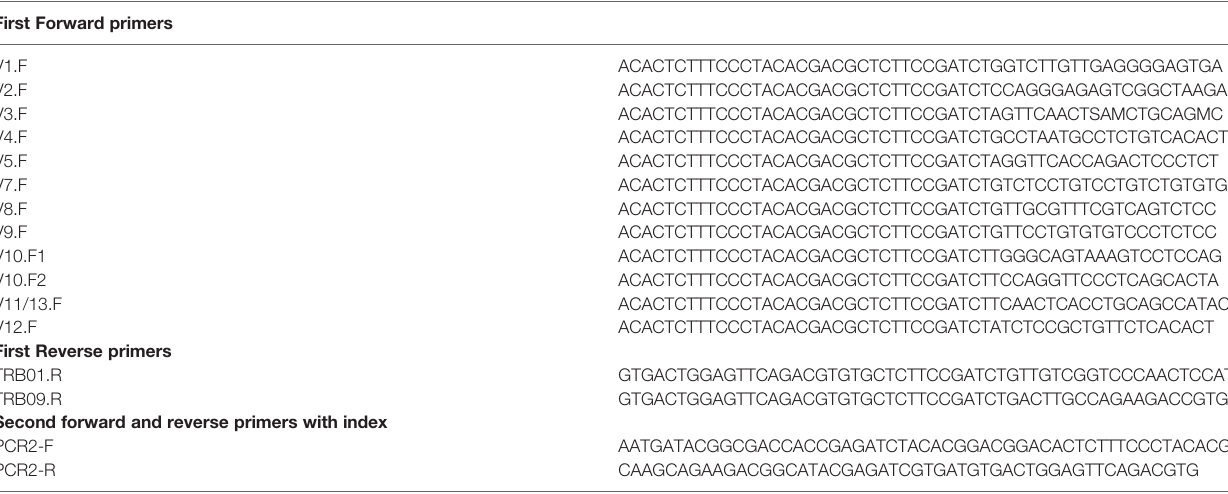
TABLE 1 | Primer sequences used in this